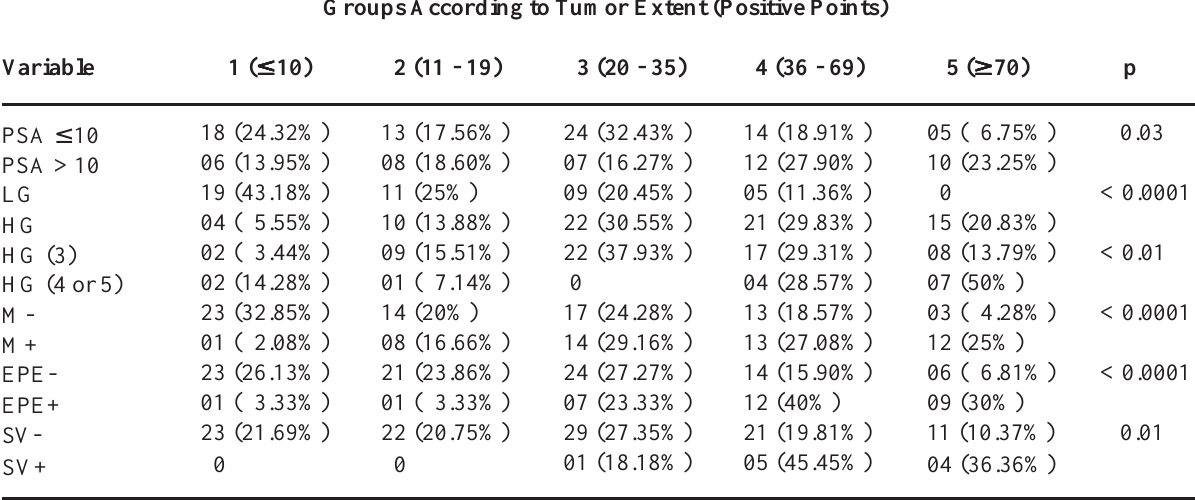
Groups According to Tumor Extent (Positive